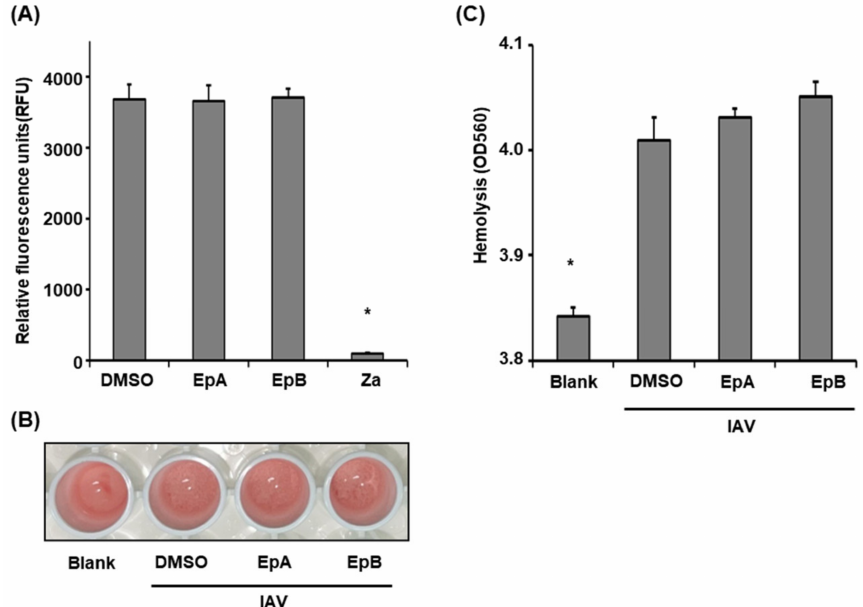
Figure 5. Effects of ethyl pheophorbides a and b on viral major surface glycoproteins. ( A ) IAV was treated with ethyl pheophorbide a (EpA, 1 µ g/mL) or b (EpB, 1 µ g/mL) for the NA inhibition assay. Zanamivir (Za, 1 µ M), an NA inhibitor, was used as the control. ( B , C ) IAV was treated with ethyl pheophorbide a (1 µ g/mL) or b (1 µ g/mL) and HA inhibition was examined using ( B ) hemolysis inhibition and ( C ) hemagglutination inhibition assays. Experiments were performed in triplicate. * p < 0.05 (Student’s t